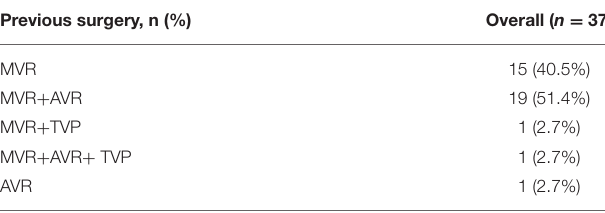
TABLE 1 | Previous left-sided valve